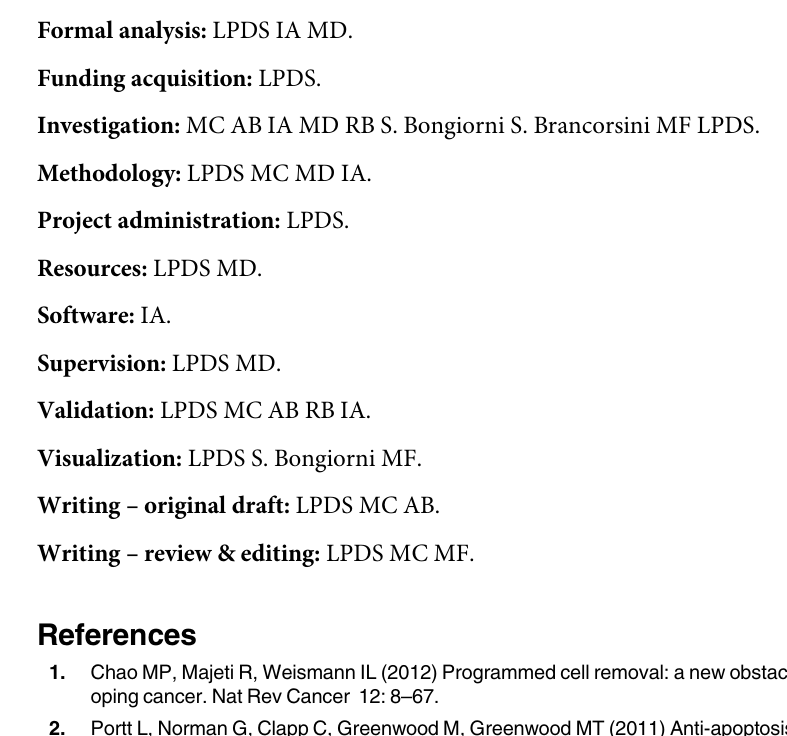
S1 Table. Differentially expressed mRNA transcripts. The 6 lists correspond to the same 6 comparisons shown in the Venn diagrams of Fig 2. Transcripts were selected, on filtered data- set (see Methods) by a combination of fold change and moderated T-test thresholds by the R-Bioconductor tool Limma (p-value < 0.05; |Log2 fold-change ratio| > 0.56 equivalent to 1.5 fold in linear